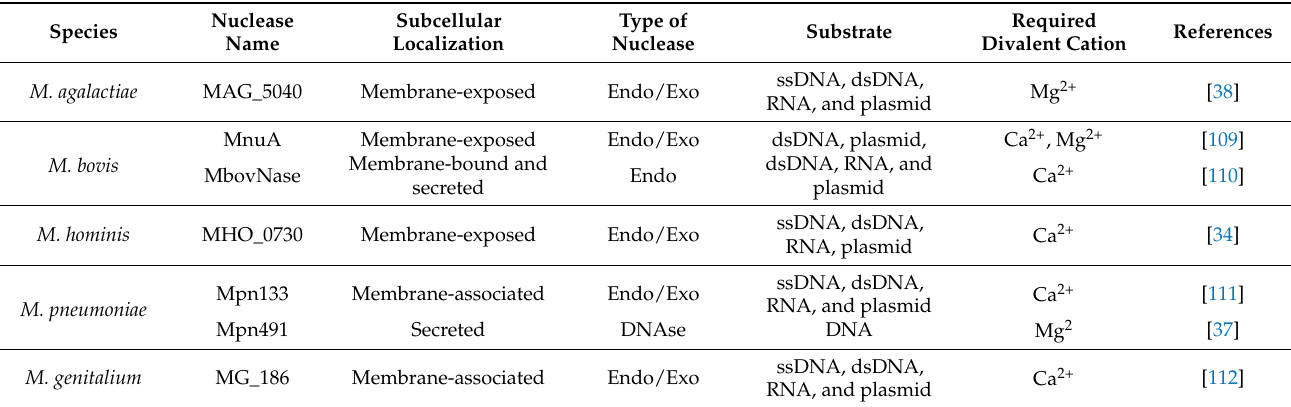
Table 1. Mycoplasma nucleases